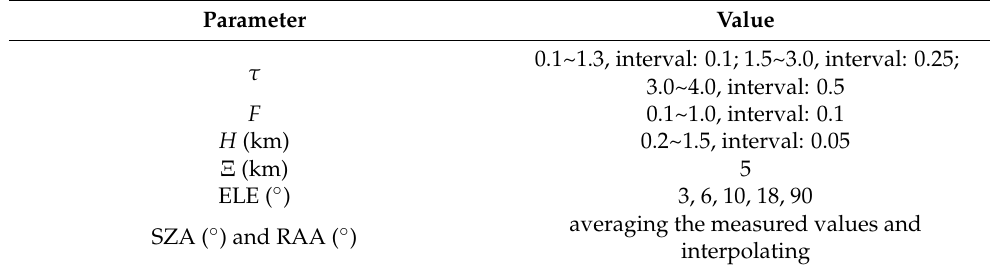
Table 2. Parameters for the lookup table.